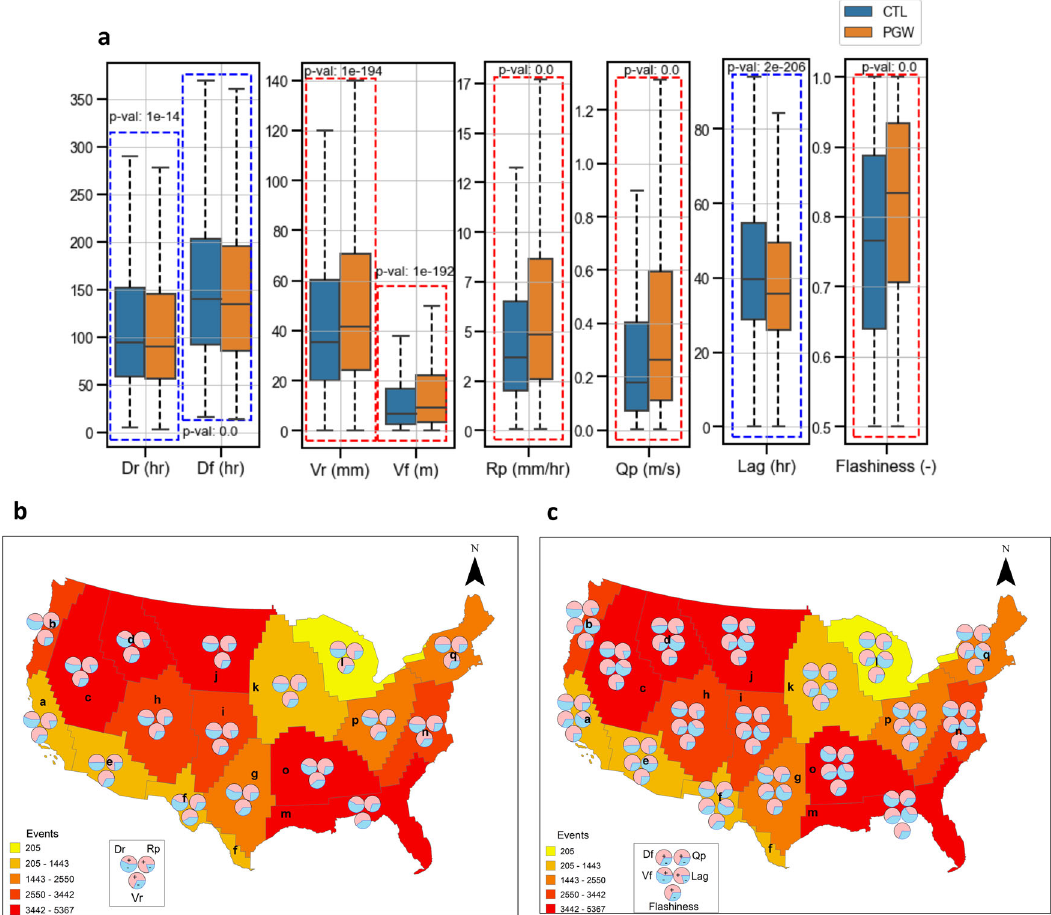
Fig. 3 Future rainfall/ fl ood durations and rainfall- fl ood lag time are decreasing while rainfall/ fl ood peak values, volumes, and fl ashiness index are increasing. a Boxplot of CONUS-wide statistics of rainfall- fl ood characteristics where blue dotted line indicates a future decrease while red dotted line indicates a future increase. Meaning of boxplot elements: central line: median, box limits: 25th and 75th percentiles, upper whisker: 75th percentile plus 1.5 times interquartile range, lower whisker: 25th percentile minus 1.5 times interquartile range. b Maps of the fraction of increase (red) or decrease (blue) for rainfall characteristics (Dr – duration, Rp – peak rates, and Vr - volume) at Bukovsky climate divisions. c Map of the fraction of increase (red) or decrease (blue) samples for fl ow characteristics (Df duration, Vf volume, Qp peak rates, Lag rainfall- fl ood-peak lag time, and Flashiness) at Bukovsky climate divisions. Shaded colors in b and c indicate the sample sizes. The blue (red) dashed box indicates a signi fi cant decrease (increase) of each feature ( p -value <0.05). The signi fi cance test is conducted by Kolmogorov – Smirnov test. Maps are produced using the